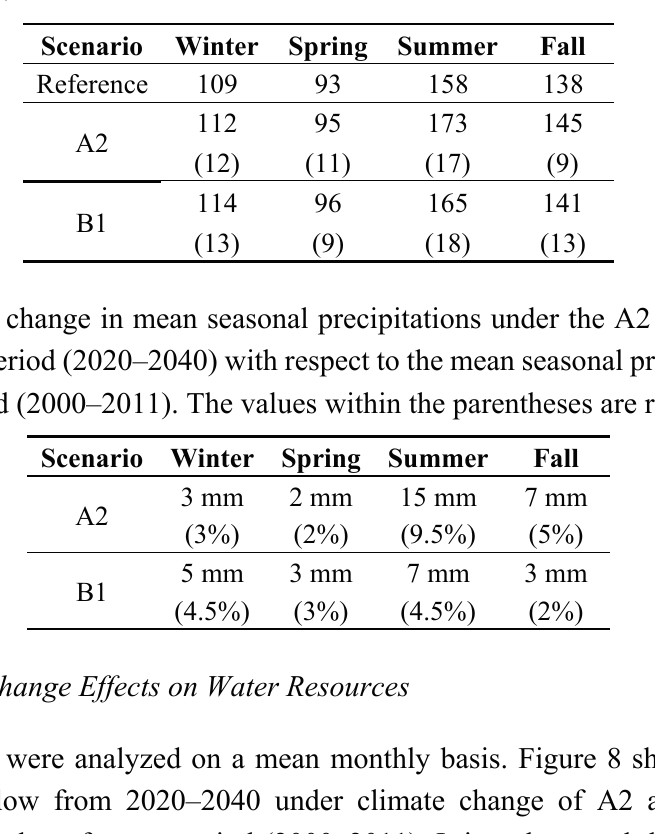
Figure 7. Comparison of projected mean monthly temperatures under the A2 and B1 scenarios from 2020 to 2040 with respect to those of 2000–2011. Table 1. Mean seasonal precipitations under the reference period (2000–2011) and A2 and B1 scenarios for the long-term period (2020–2040). The values within the parentheses are standard deviation among mean seasonal precipitations from 2020 to 2040. The unit of precipitation is mm.